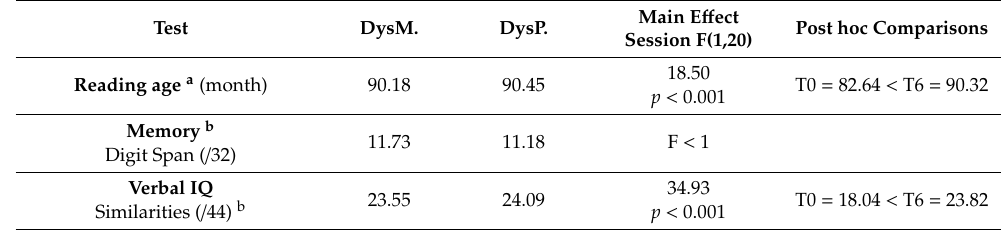
Table 2. Results of children with dyslexia (DysMus and DysPaint) after 6 months of training, on measures of memory, verbal and nonverbal intelligence, phonology, reading regular and irregular words and pseudo-words, and visual and auditory attention. T0: before the start of the experiment and T6: six months